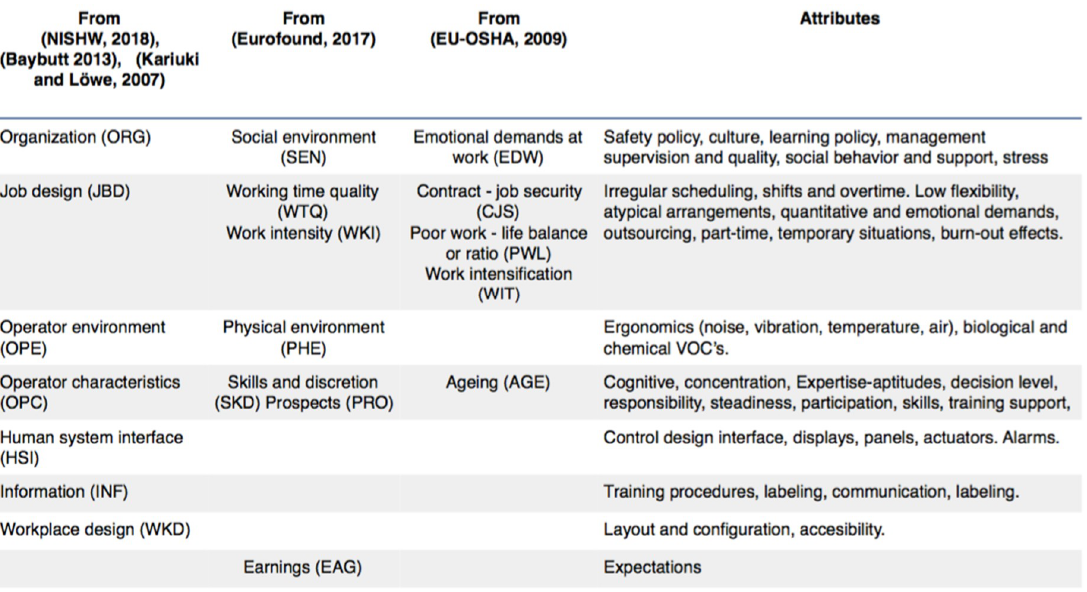
Figure 9. Factors and attributes affecting human behavior at work.